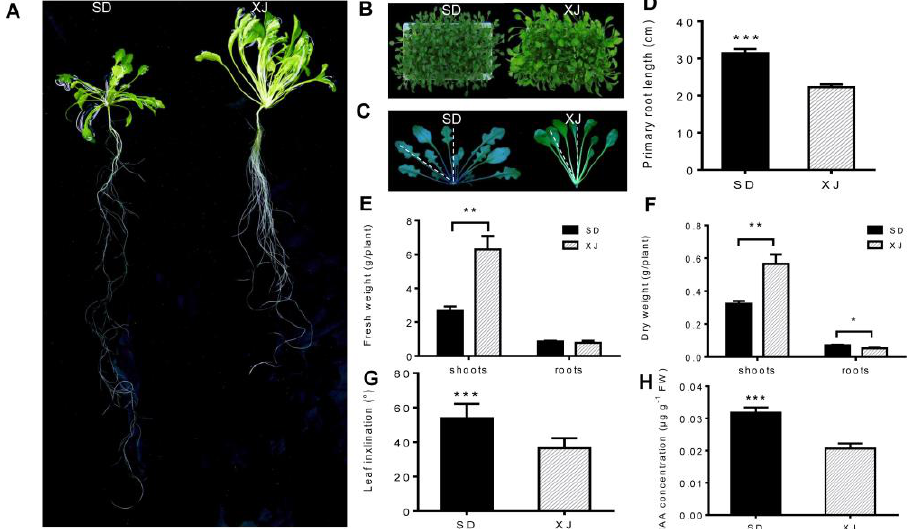
Figure 1. Growth and morphological analysis of SD and XJ plants cultured in a hydroponic system for 6 weeks. ( A , B ) Growth status of SD and XJ plants. ( C ) Comparison of leaf inclination angles of SD and XJ plants after 6 weeks of hydroponics. ( D – F ) The primary root length, fresh weight (FW), and dry weight (DW) of two Eutrema were examined. ( G ) Leaf inclination angle measurements were made between the central axis and the penultimate leaf of two Eutrema . ( H ) Concentration of IAA in shoots. Data were expressed as means ± SD and t -test was used for statistical analysis. (* p < 0.05, ** p < 0.01 and *** p < 0.001). All experiments were tripled, and each experiment contained at least 9 plants.